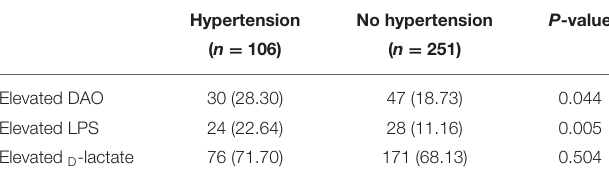
TABLE 2 | Intestinal barrier markers in patients with or without hypertension.